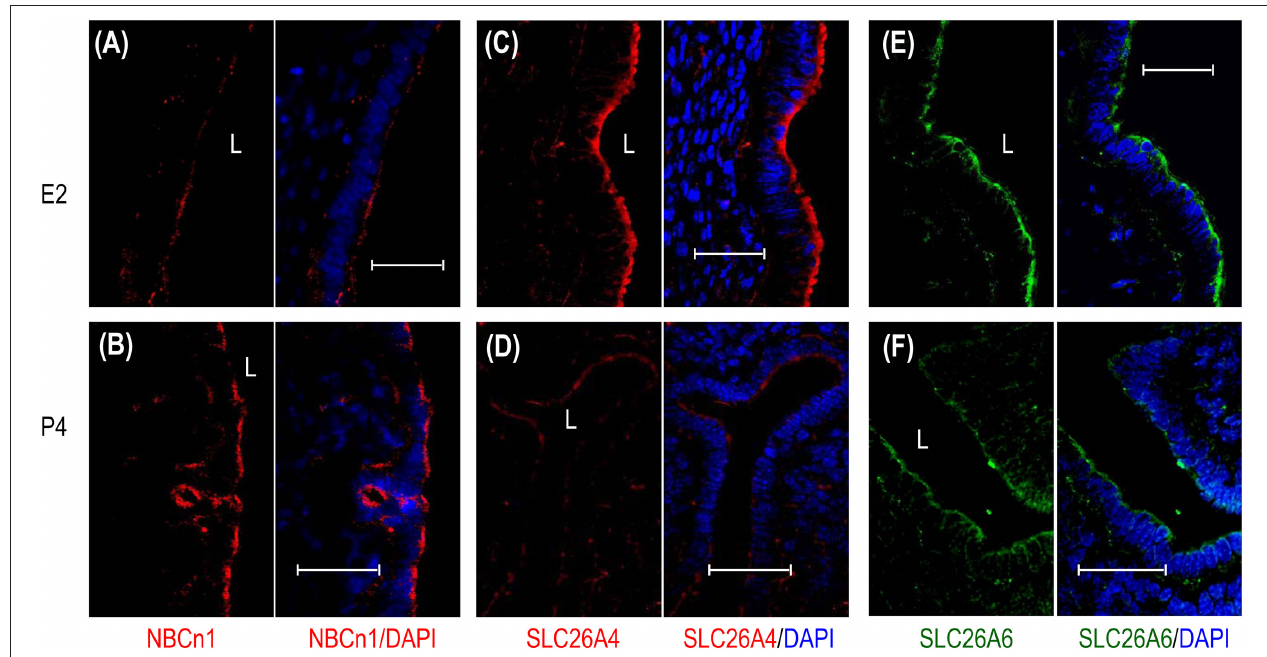
FIGURE 6 | Effect of β -estradiol (E2) and progesterone (P4) on cellular expression of NBCn1, SLC26A4, and SLC26A6 in uteri of ovariectomized mice. (A,B) NBCn1 in the uterus from a mouse treated with E2 (A) or P4 (B) . (C,D) SLC26A4 in the uterus treated with E2 (C) , or P4 (D) . (E,F) SLC26A6 in the uterus treated with E2 (E) or P4 (F) . To compare the effects of E2 vs. P4 on the expression of a given transporter, immunofluorescence staining was always performed in parallel with the sections treated with either E2 or P4, and images were then acquired with the same set of parameters on the confocal microscopy. L: uterus lumen. Scale bars: 40 µ m. Results are representative of 3–4 independent experiments with sections from three different mice for each treatment (E2 vs. P4).